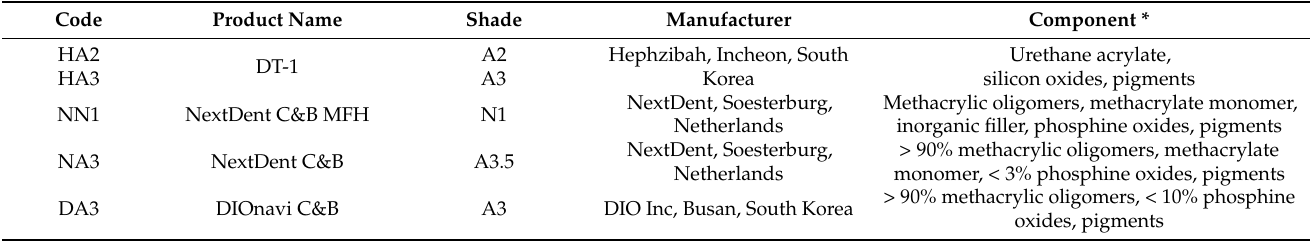
Table 1. 3D printable dental materials for crown and bridge restorations used in this